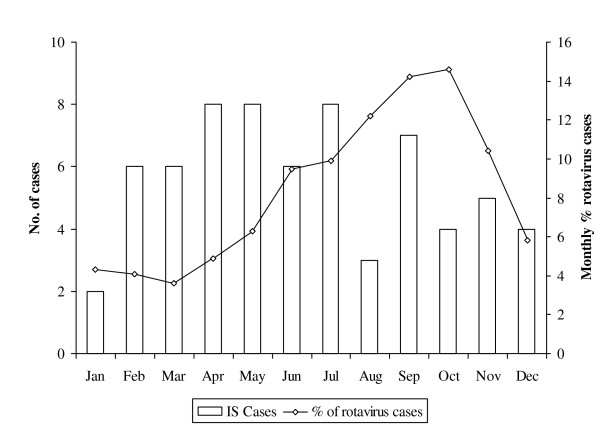
Monthly distribution of intussusception in children aged <24 months, Bukhara region, Uzbekistan, 2004-2008.